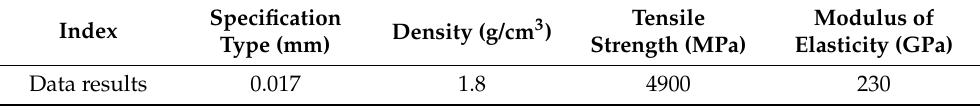
Table 3. Technical indexes of micro carbon fiber.